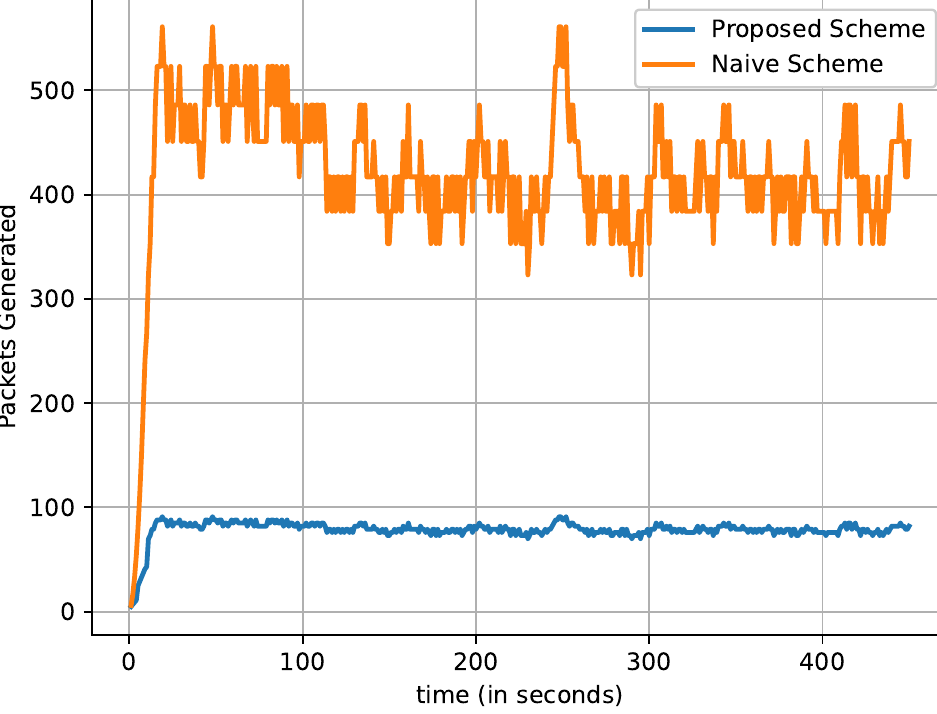
Figure 6. Total number of generated critical data packets at every iteration (time in seconds).